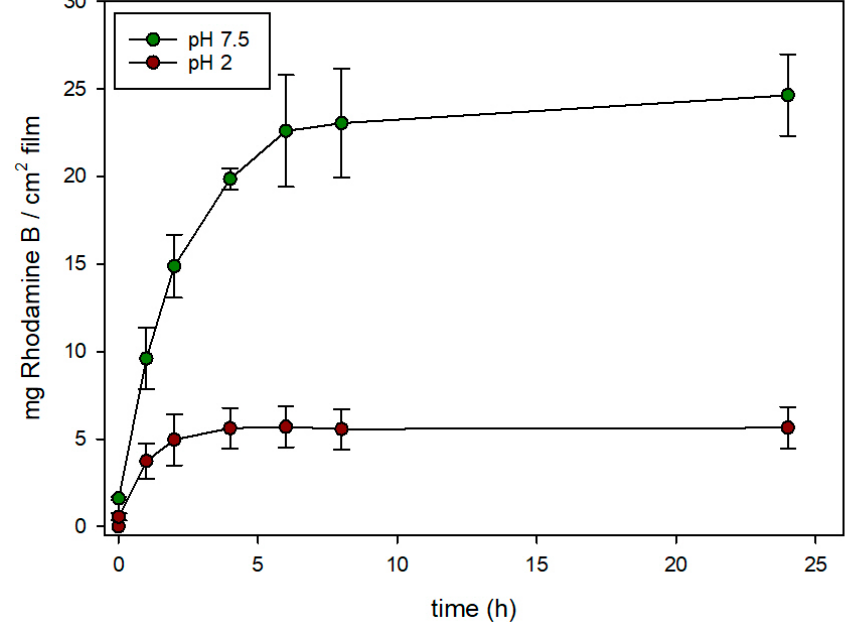
Figure 6. Evolution of rhodamine B release from EVOH 32-N-Rh-N3 prepared at pH 3 in aqueous media at acidic pH (pH = 2) and at neutral pH (pH = 7.5).